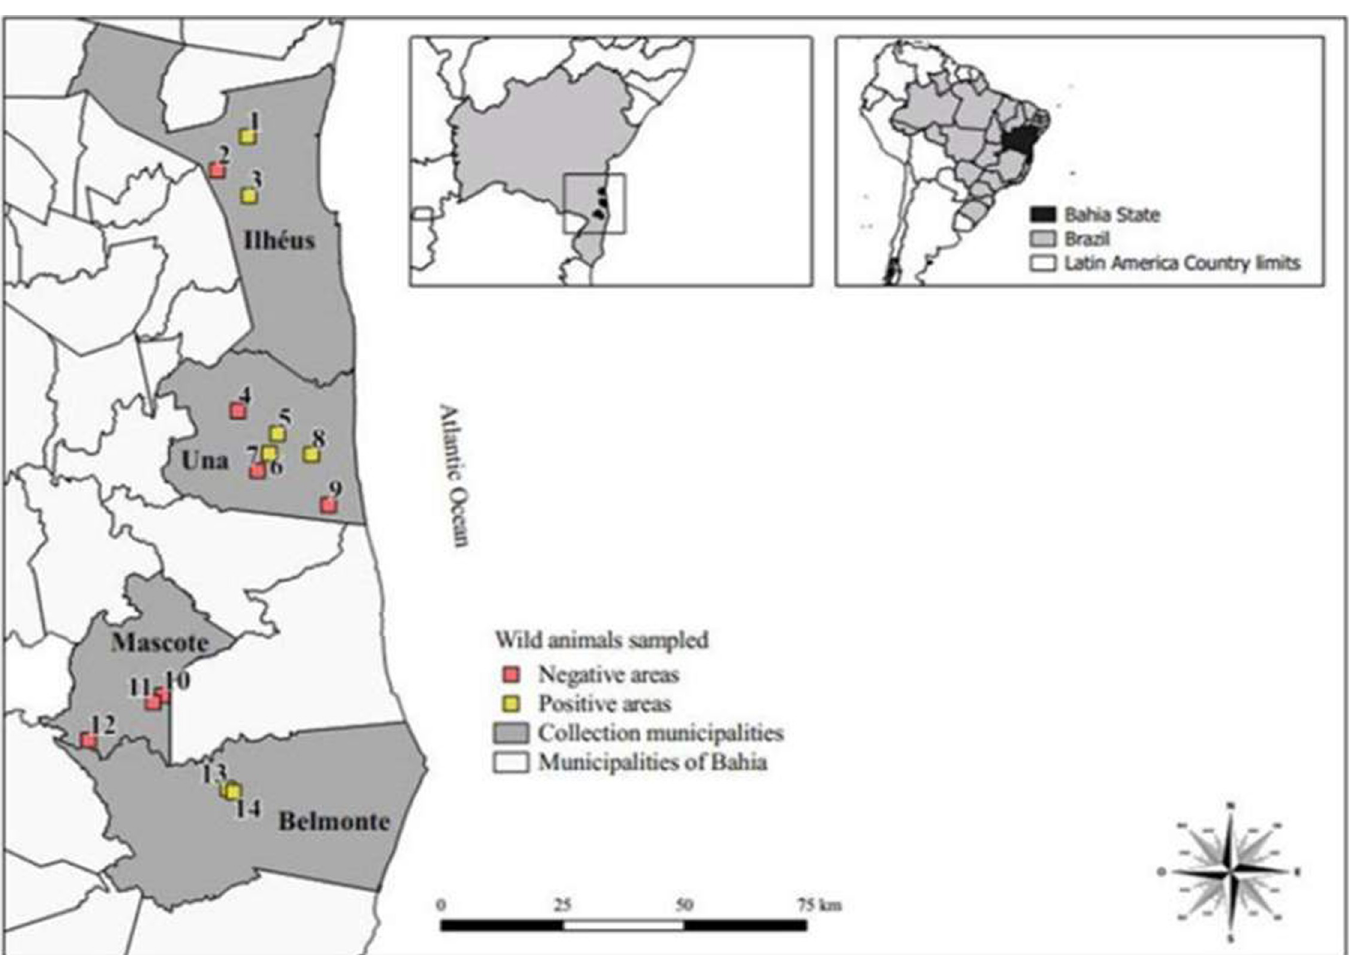
Fig 1. Map depicting the capture and collection areas, of fecal samples from rodents and marsupials in southern Bahia, northeastern Brazil. Geographic coordinates of the collection points. 01 : 14°38’15 . 8”S39°12’02 . 3”W; 02 : 14°42’11 . 2”S 39°15’34 . 8”W; 03 : 14°45’04 . 0”S 39°11’51 . 2”W; 04 : 15°09’57 . 8”S 39°13’10 . 1”W; 05 : 15°12’35 . 9”S 39° 08’37 . 4”W; 06 : 15°14’53 . 1”S 39°09’34 . 3”W; 07 : 15°16’54 . 5”S 39°10’54 . 2”W; 08 : 15°14’59 . 0”S 39°04’41 . 0”W; 09 : 15°20’53 . 0”S 39°02’43 . 5”W; 10 : 15°42’53 . 6”S 39°21’52 . 6”W; 11 : 15°43’40 . 9”S 39°22’56 . 7”W; 12 : 15°48’01 . 9”S 39°30’23 . 8”W; 13 : 15°53’40 . 4”S 39°14’19 . 2”W; 14 : 15°54’03 . 0”S 39°13’40 . 4”W